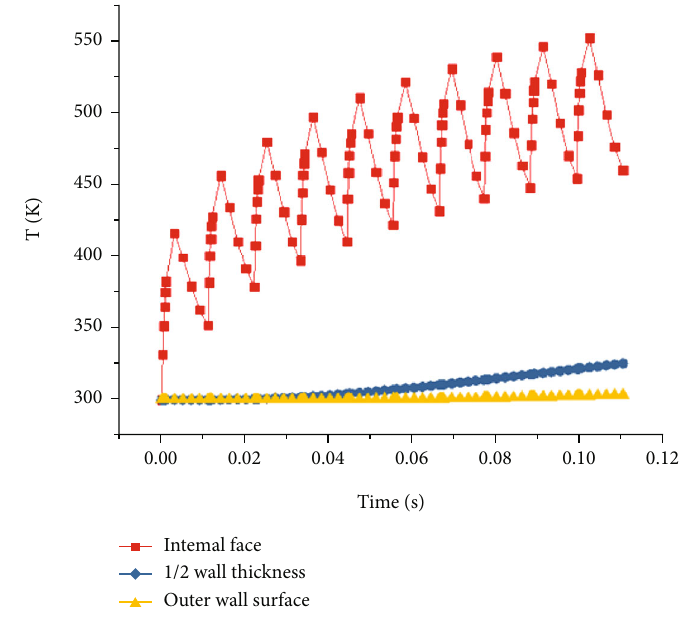
Figure 12: Time history curve of the inner wall surface temperature during continuous fi ring.